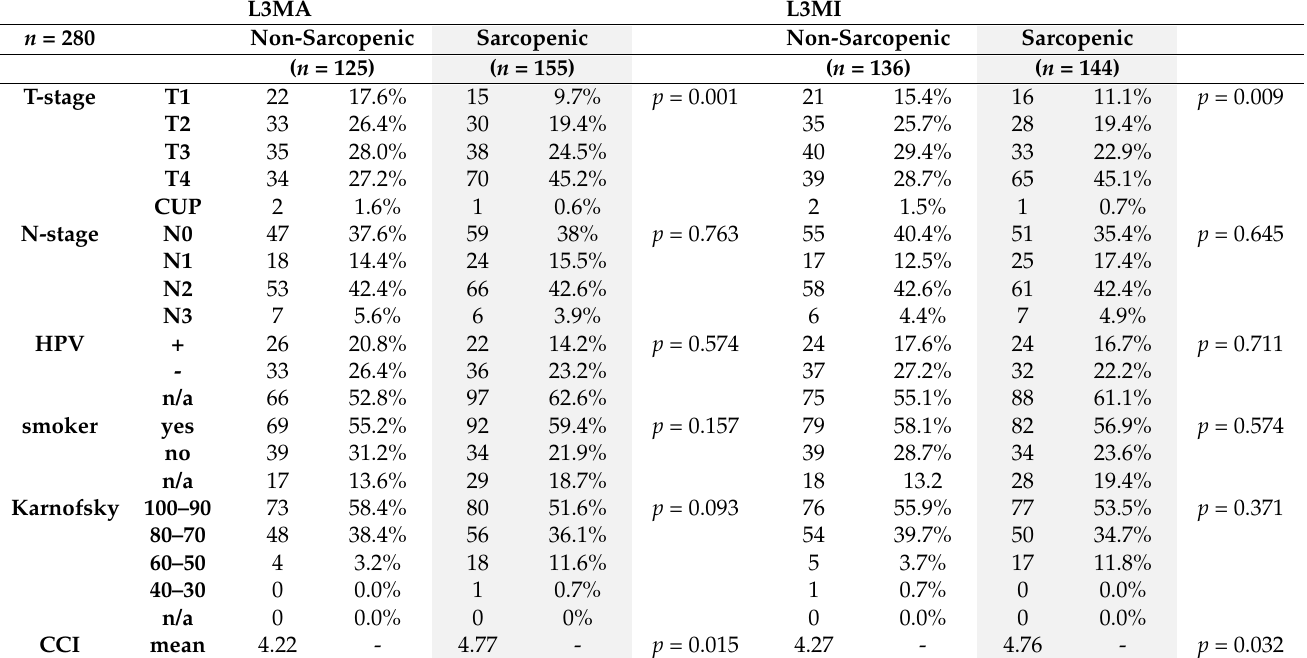
Table 1. Comparison of clinico-pathological parameters for pretherapeutic sarcopenic and non- sarcopenic elderly HNSCC patients undergoing curative (chemo)radiotherapy. p values given for group comparison with Mann–Whitney U tests and Fisher’s exact tests. L3MA, calculated cross- sectional skeletal muscle area at the third lumbar vertebra; L3MI, calculated skeletal muscle index at